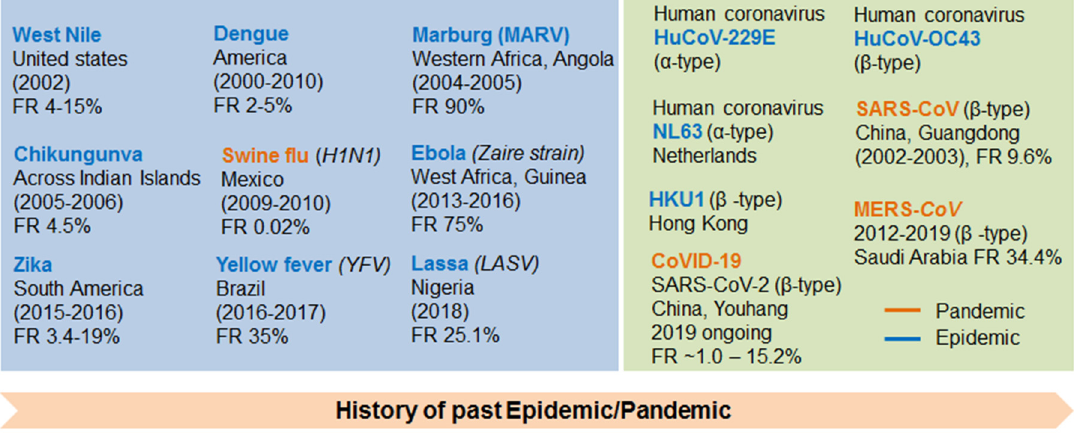
Figure 1. Viral pandemics in the 21st century and their fatality rate (FR) (Upper left) . Discovery of human coronaviruses and their FRs (Upper right): Pharmaceutical companies developing COVID-19 vaccine and their clinical stages (Lower).